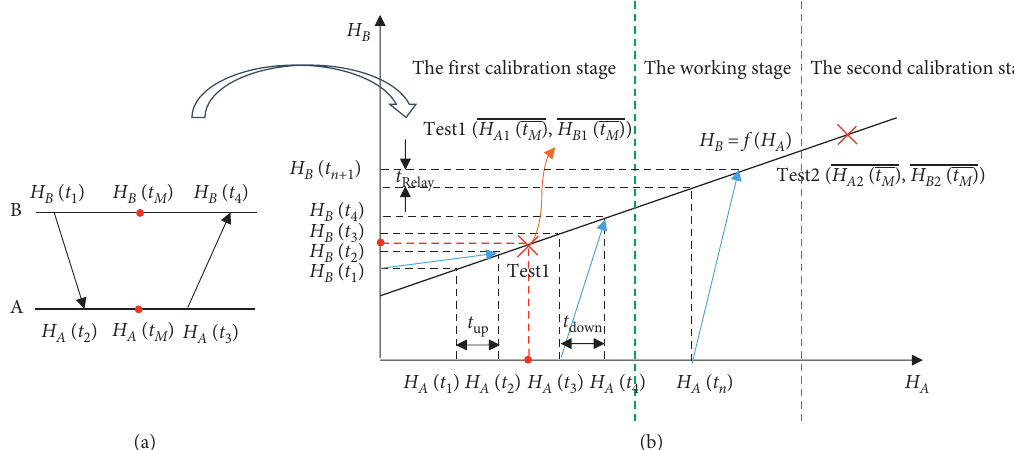
Figure 3: Obtain the relative offset and relative skew of the clock relationship by using the NTP time model. (a) NTP time model. (b) Clock relationship of A - and B -terminals.